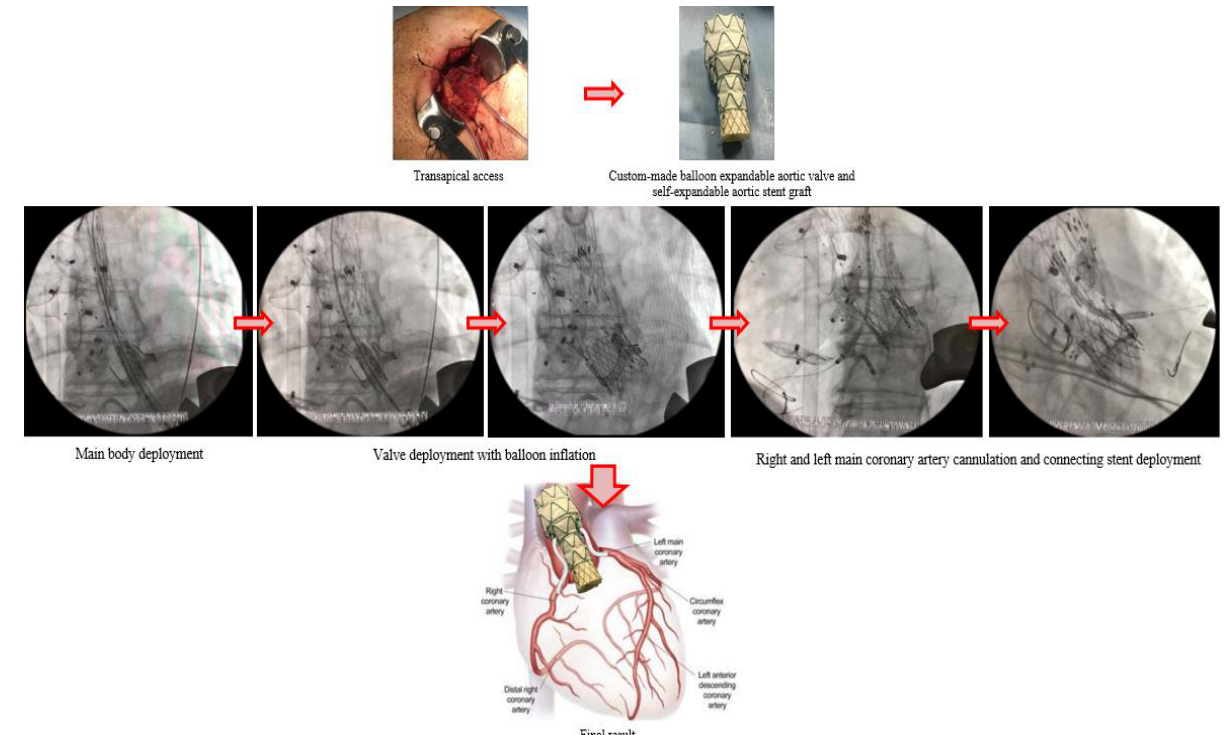
Figure 7. Figure reporting the step-by-step procedure published by Gaia in 2020. First, a femoral arterial access for angiography and femoral venous access for pacing are obtained; RCA and LMCA are cannulated; then a transapical access with a 30 Fr introducer is obtained; consequently, endoprosthesis is positioned and deployed; after that, balloon expandable prosthetic aortic valve is deployed. Then, RCA and LMCA are cannulated through endoprosthesis main body and coronary branches and connecting stents are finally deployed. Courtesy of Professor Diego Gaia, Federal University of Gandet in 2021 used a modified endograft with three fenestration for coronary ostia Table 1. Summary of Literature of endo-Bentall techniques and